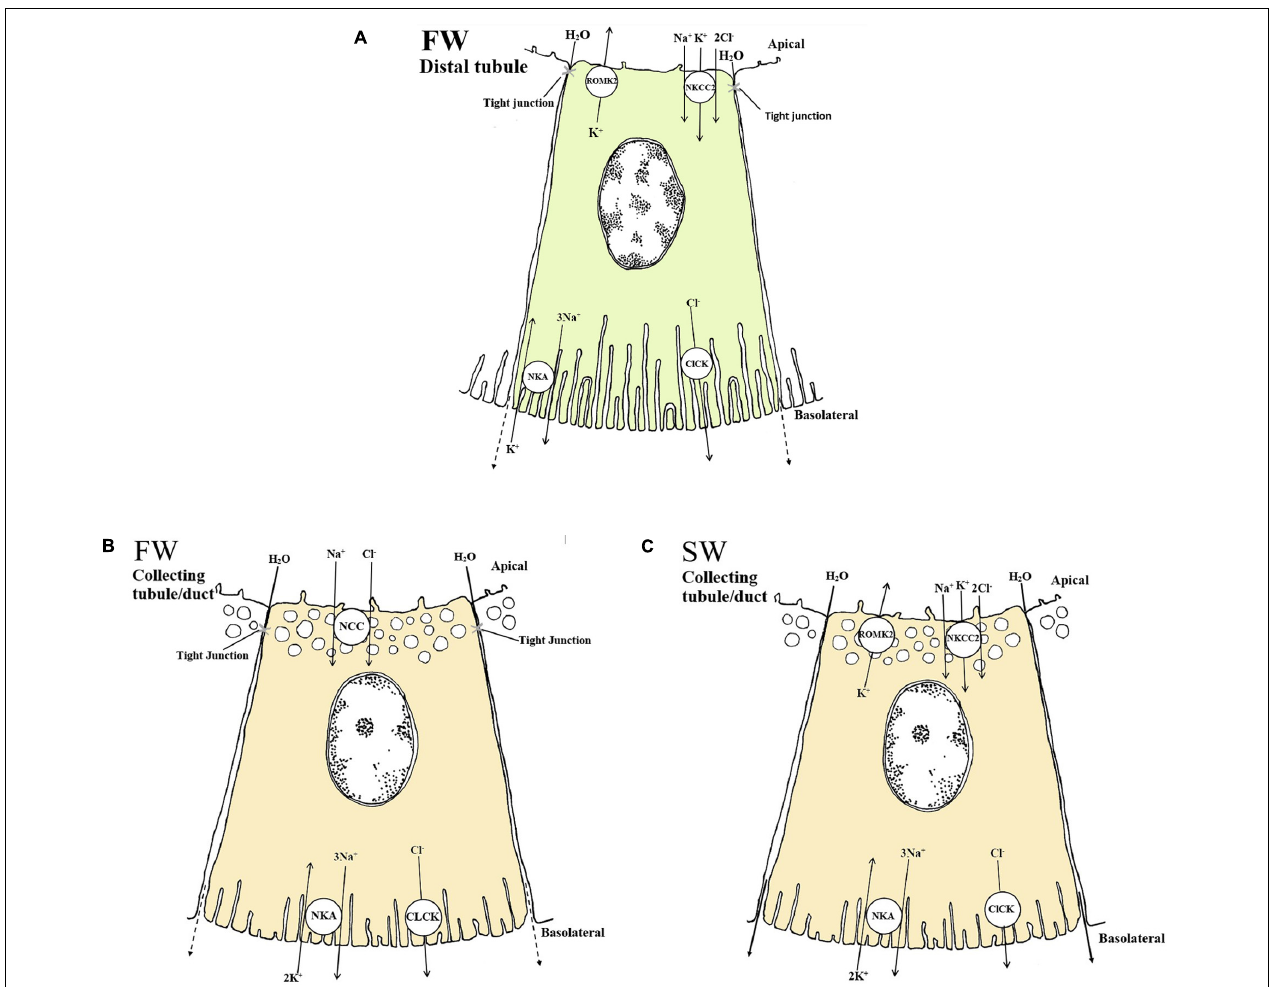
FIGURE 3 | Schematic overview showing localization and mechanisms of Na + , Cl − and K + transport in FW (A and B) and SW (C) teleosts. (A and B) The basolateral Na + - K + - ATPase (NKA) generates a favorable transeptial membrane potential used by other ion transporters. In FW urine dilution likely occurs through the apically located NKCC2 in the distal tubule which reabsorbs luminal Na + , K + and Cl - through a concentration gradient under water impermeable conditions (A) . The cytosolic Cl - are further passed into the interstitial space via the chloride channel (CLCK), while the apical K + channel (ROMK2) maintain the luminal K + concentrations creating a lumen positive transepithelial voltage necessary for Na + , K + and Cl − absorption through the NKCC2. In the collecting duct of FW fish NCC further reabsorbs Na + and Cl − aided by the basolateral NKA and CLCK transporters (B). (C) In SW the mechanisms of NaCl absorption is likely similar to those in the distal tubule of FW fish, only here the tubules are permeable to water and the NaCl absorption is likely accompanied by water. The ROMK2 and CLCK are based on expression profiles in the pronephric duct of zebra fish (Wingert et al., 2007), tilapia (Miyazaki et al., 2002) kidneys as well as the mammalian model (Nielsen et al., 2002) for all the models. All models are based on the paper of Katoh et al. (2008) and Kato et al.